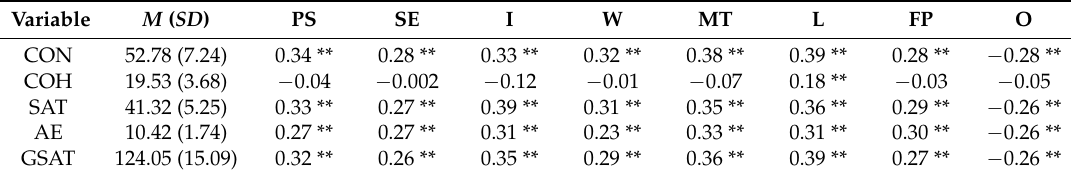
Table 1. Pearson’s linear correlation coefficient for general relationship satisfaction and its components with a sense of stress and its